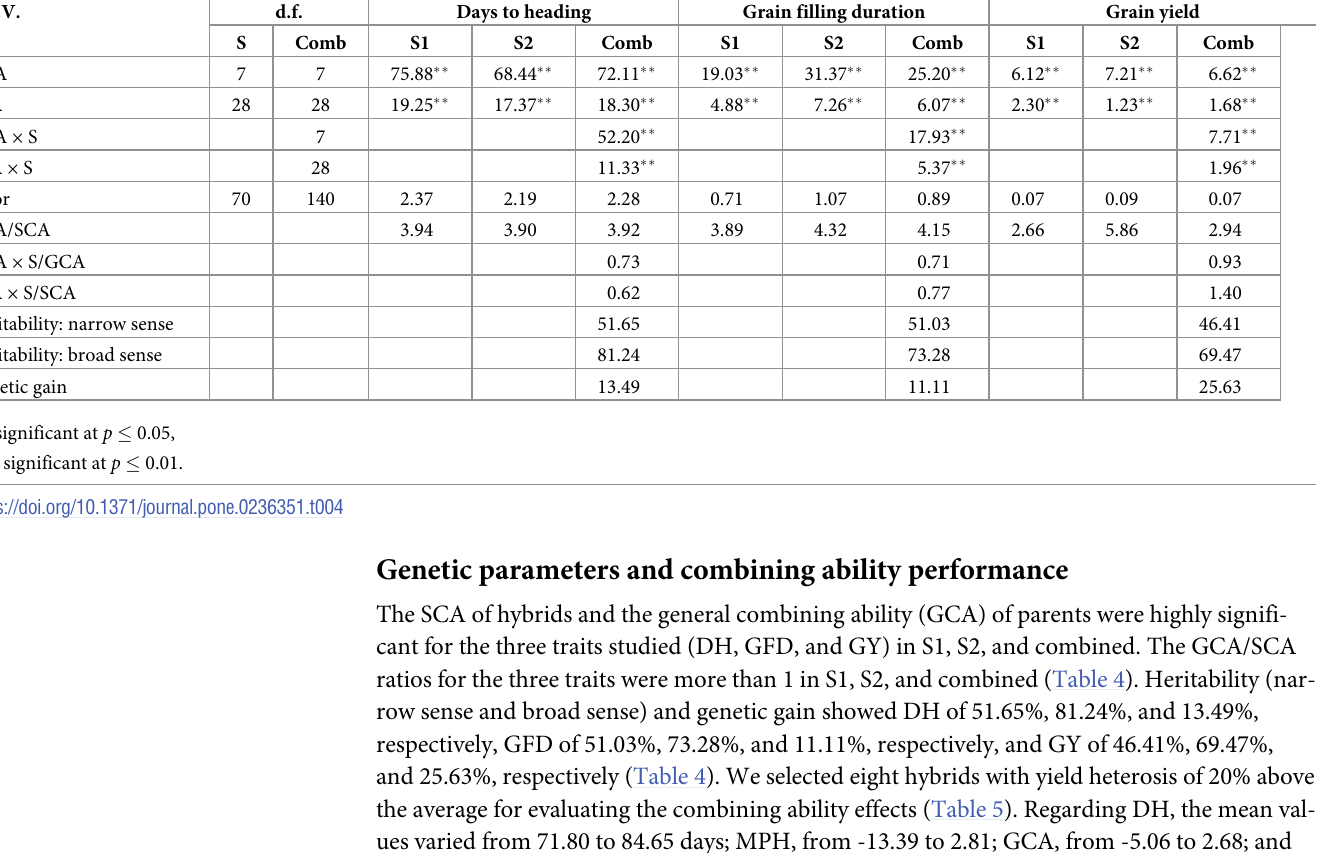
Table 4. Mean squares of general (GCA) and specific (SCA) combining ability for days to heading, grain filling duration, and grain yield for each and across seasons of parents and their F 1 hybrids in bread wheat genotypes, and heritability and genetic gain values for traits across seasons. S.O.V.